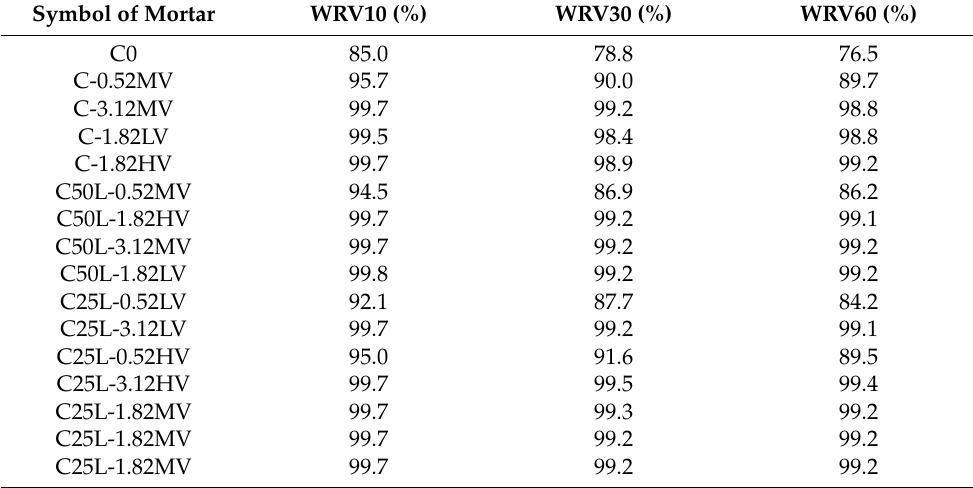
Table 7. Water retention